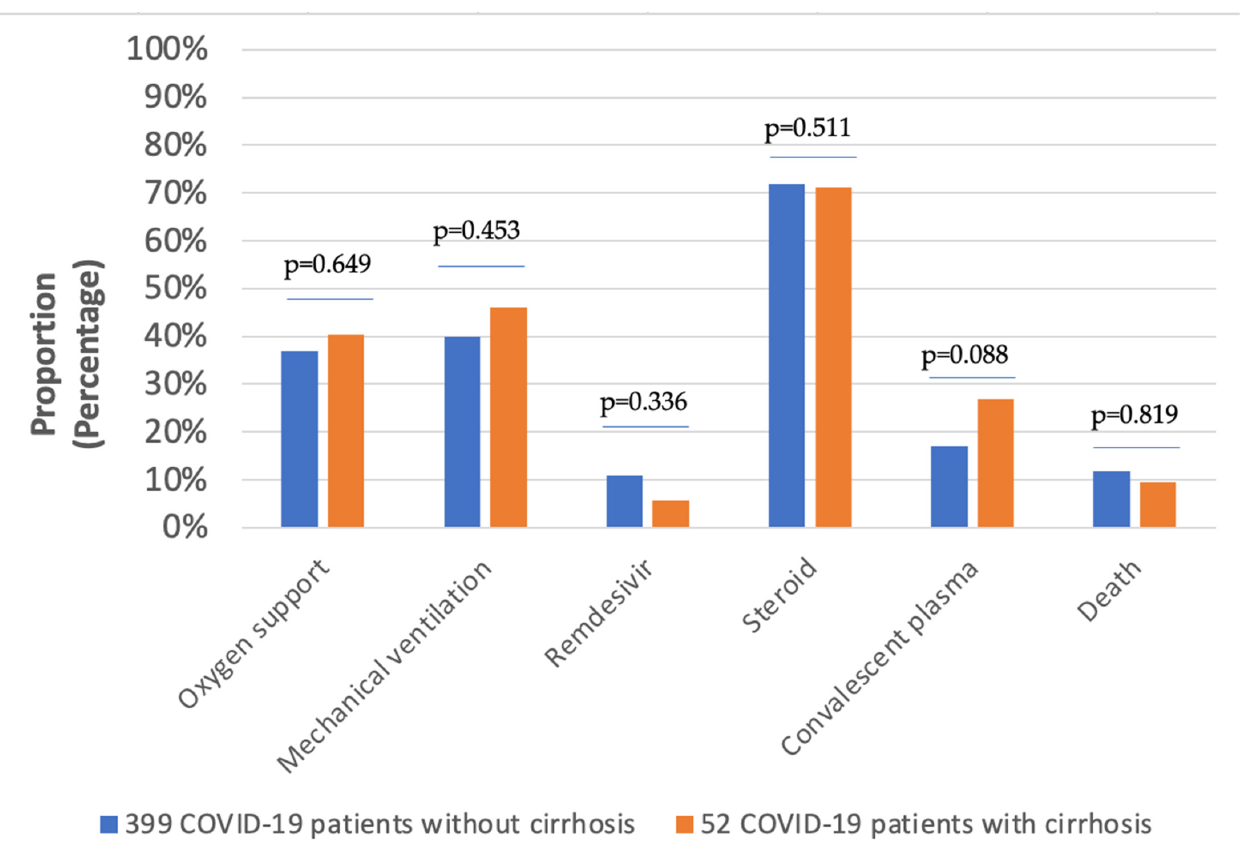
Figure 3. Treatment and hospital outcomes in COVID-19 patients.